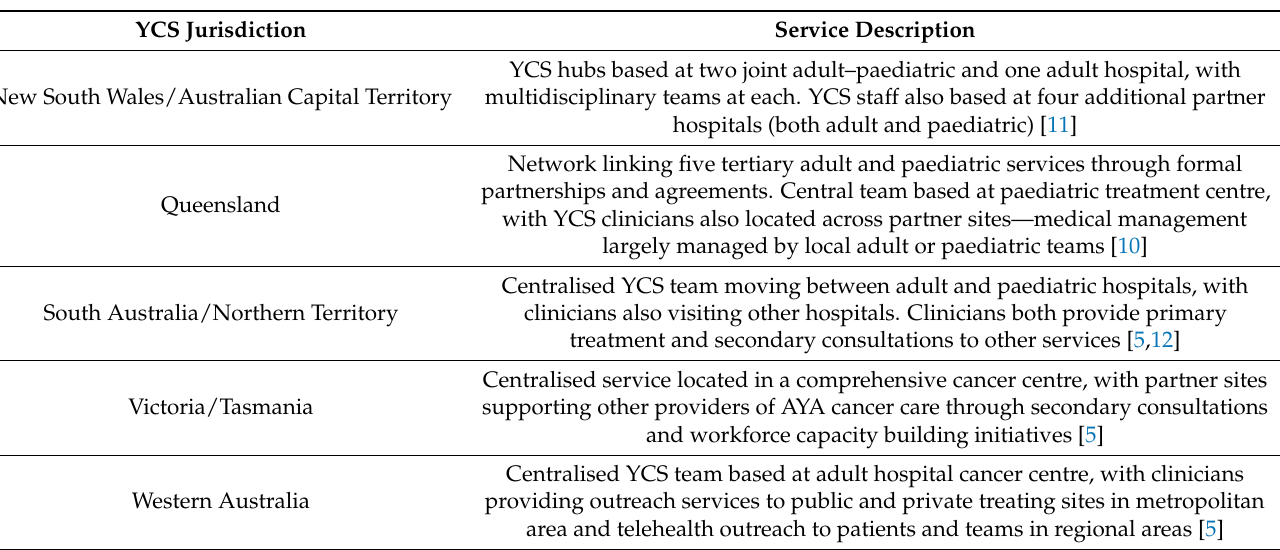
Table 2. YCS service